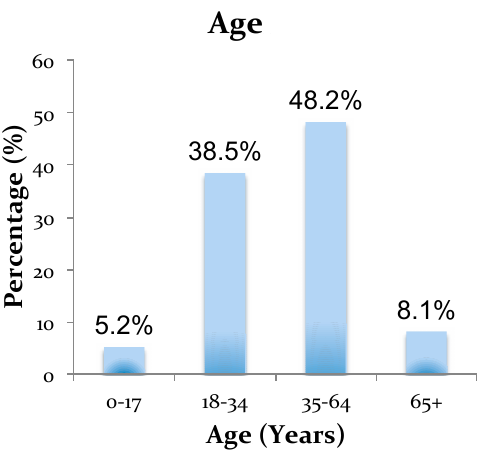
Figure A1. Age differences among self ‐ inflected harm (SIH) cases.